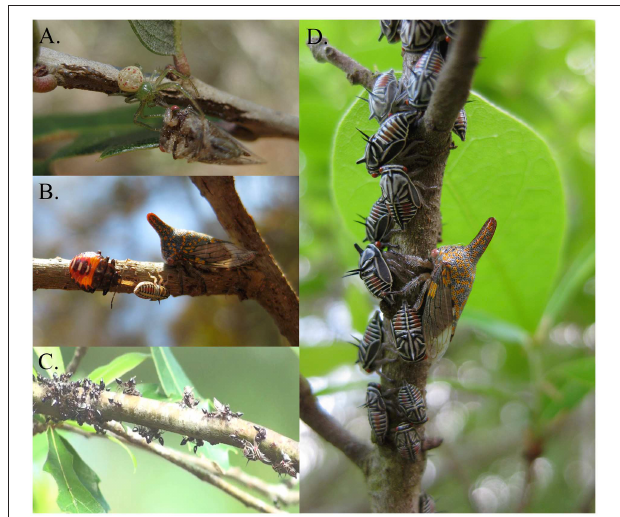
FIGURE 1 | Vibrationally-sensitive insect predators of oak treehoppers (A–C) and an oak treehopper family (D) . (A) Crab spider carrying oak treehopper mother; egg clutch is visible on the branch, underneath the spider. (B) Predatory stink bug nymph (introduced by author) feeding on oak treehopper nymph. (C) Arboreal ants ( Crematogaster ashmeadii ) preying upon oak treehopper nymphs. (D) Oak treehopper mother and late instar